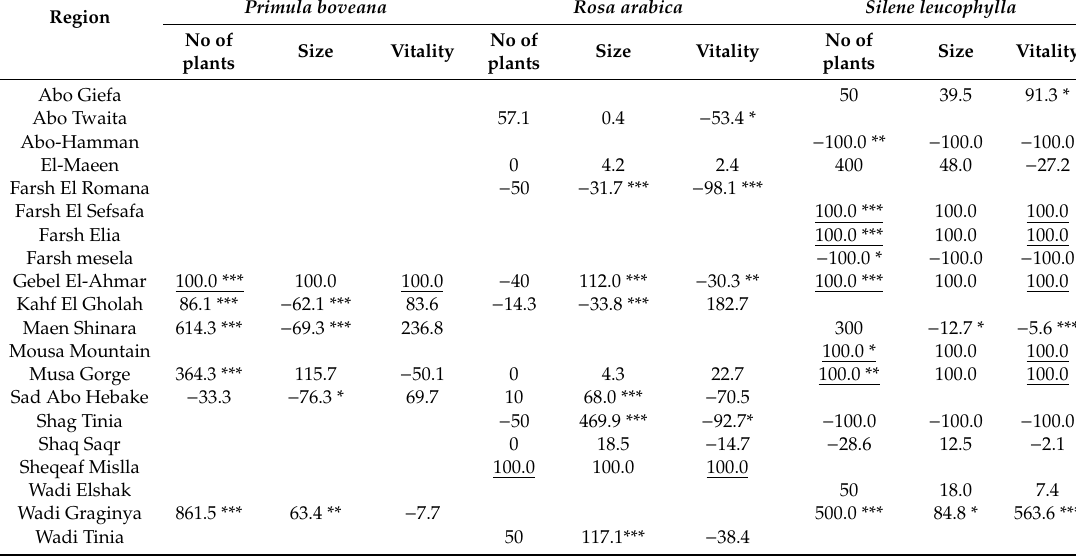
Sheqeaf Mislla 100.0